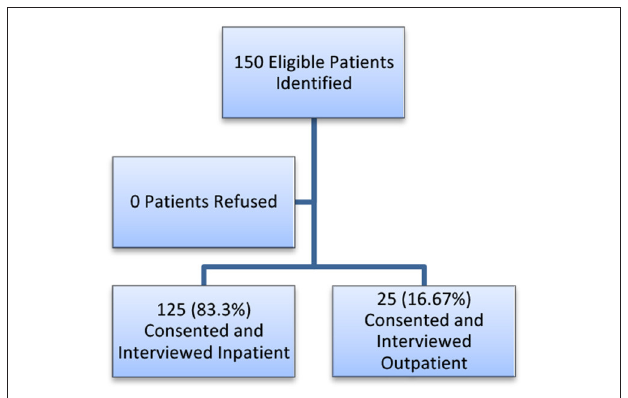
FIGURE 1 | Patients consented and enrolled in the study.